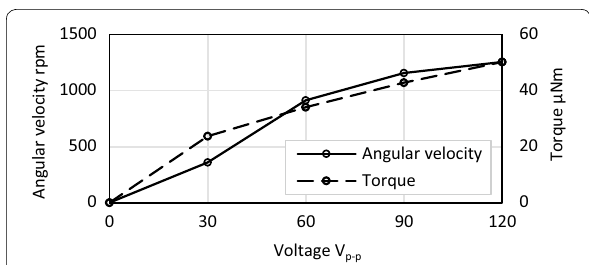
Fig. 12 Relationship between the voltage amplitude and the motor output under a constant preload of 8.9